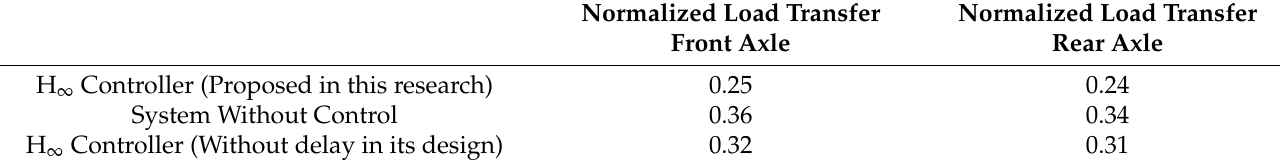
Table 3. Normalized Load Transfer for test 1.